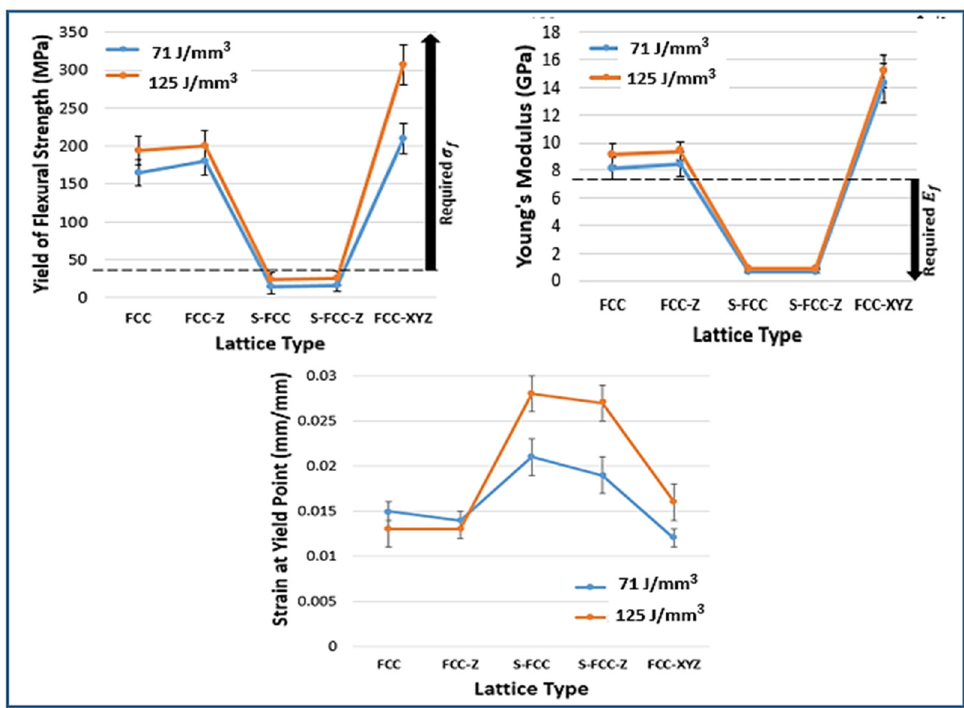
Figure 12. The flexural properties of SLMed objects with five types of lattice structures, yield strength at 0.02 offset from the first plateau start, Young’s modulus, and elongation at yield.